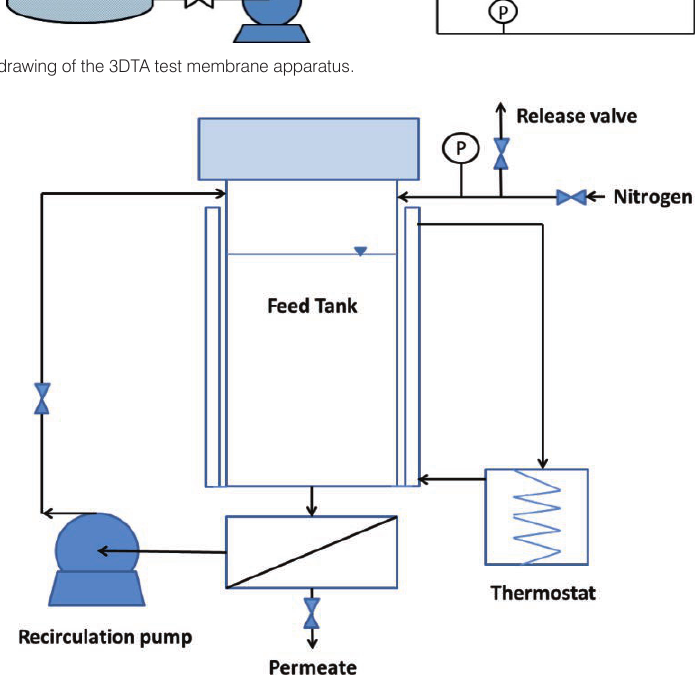
Figure 2. Schematic drawing of Celfa P-28 test membrane